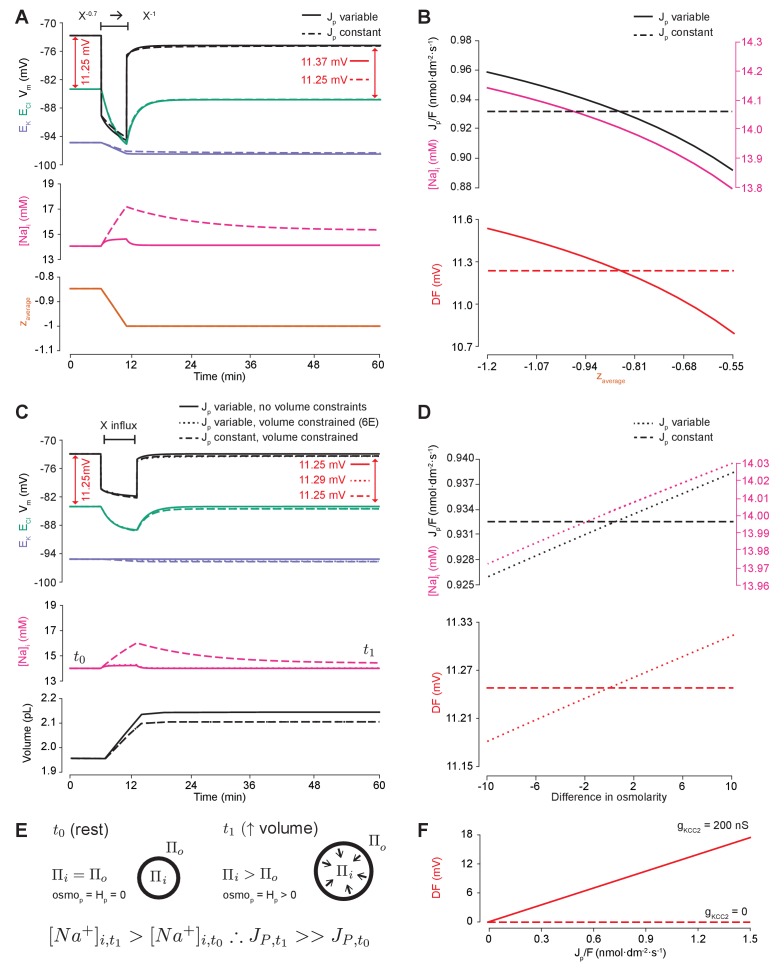
Impermeant anions drive small shifts in chloride driving force by modifying the Na+/K+-ATPase pump rate under conditions of active chloride cotransport.(A) ECl (green), EK (purple) and Vm (black) (top panel), [Na+]i (pink, middle panel) and mean impermeant anion charge z (orange, lower panel) over time in the default single compartment model. Changing z from −0.85 to −1 generated small, persistent Cl- driving force (DF) shifts (arrows, red) only when the effective ATPase pump rate (Jp) was variable (solid line) and not when Jp was kept constant (dashed line). (B) Solving analytically across different values of z with either a variable Jp (solid lines) or a constant Jp (dashed line), demonstrates the direct relationship between Na+ (pink), effective pump rate (Jp) (top panel) and DF (lower panel, red). (C) ECl (green), EK (purple) and Vm (black) (top panel), [Na+]i (pink, middle panel) and cell volume (black, lower panel) over time in the default single-compartment model. Impermeant anions of the same charge as the mean charge of the cell were added. A volume constraint was incorporated by adding a hydrostatic force dependent on membrane tension (dashed lines), which resulted in an impermeable anion-induced transmembrane osmotic differential. This caused a small change in DF when Jp was variable (dashed line), but not when Jp was held constant (dotted lines). (D) Solving analytically across osmolarity differences demonstrates the direct relationship between Na+ (pink), effective pump rate (Jp) (top panel) and DF (lower panel). Note, the small changes in DF. (E) Schematic explaining the mechanism through which impermeant anion-induced cell swelling in the presence of volume constraints (i.e. membrane tension) result in steady states with equal but non-zero osmotic (osmoP) and hydrostatic pressures (HP), causing transmembrane osmotic differences (t1). This causes small changes in Na+, and hence Jp. (F) All Na+/K+-ATPase pump rate-related shifts in the DF require KCC2 activity; in the absence of activity (dashes), no shifts in driving force can occur. In Figure 6—figure supplement 1, we show that the results in (A) and (C) are similar when an experimentally-matched model of the Na+/K+-ATPase is used.